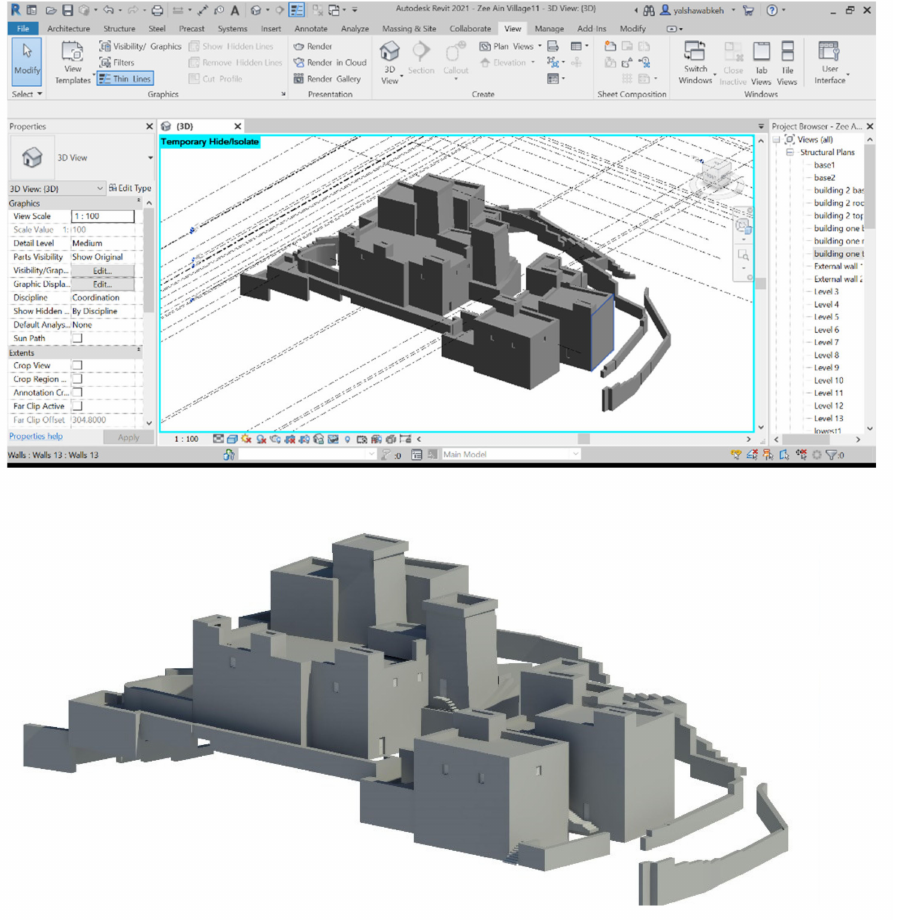
Figure 16. HBIM of Zee Ain